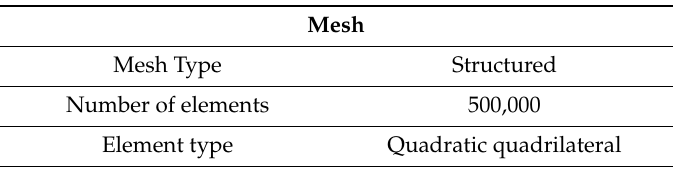
Table 3. CFD model setup